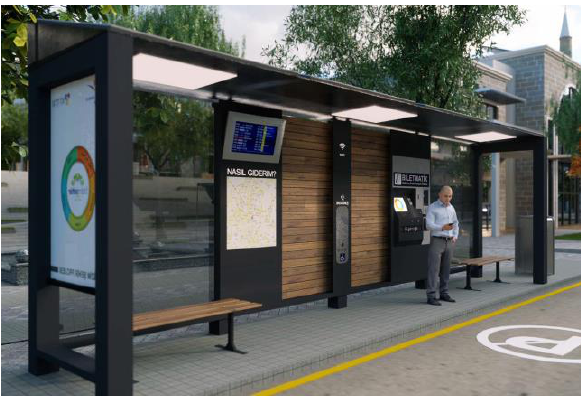
Figure 3. Designed smart bus stop for the smart city concept Measurements of air quality and sound noise will be done